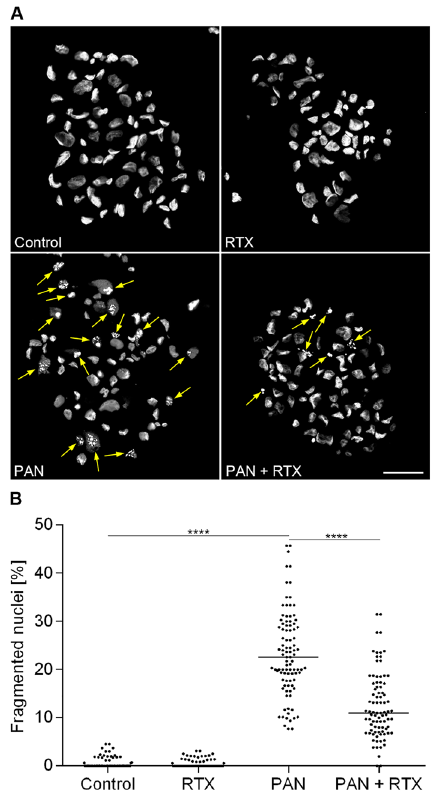
Figure 3. Rituximab prevents fragmentation of podocyte nuclei. Hoechst nuclear staining was performed for the detection of apoptosis. Apoptotic cells were defined as percentage of fragmented nuclei. ( A ) Nuclear staining (DAPI, grey) of human podocytes. Scale bar = 50 µm. ( B ) Number of apoptotic podocytes [%]. Statistics: One- way ANOVA with Tukey’s multiple comparisons test; the median [%] is shown, one dot represents one recorded